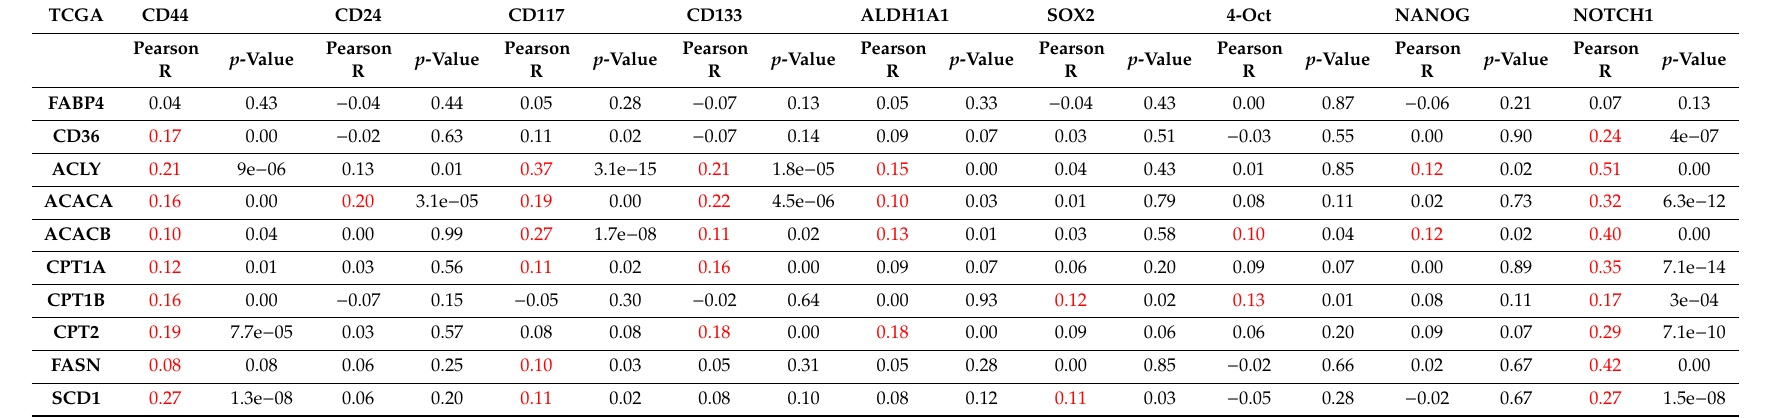
Table 4. Correlation between OCSC markers and lipid transporters and key enzymes in lipid metabolism in TCGA. Red indicates significant positive, and black indicates insignificant p -values of either positive or negative